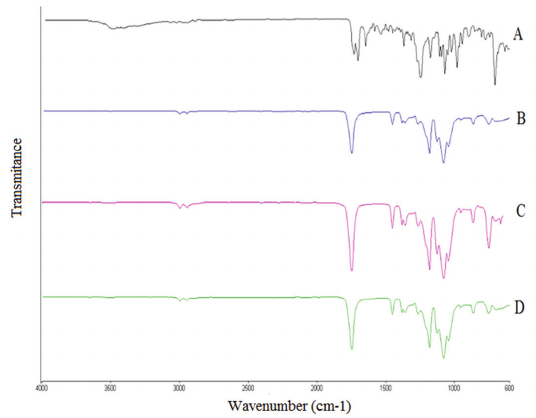
Figure 6. FTIR spectros of (A) pure paclitaxel, (B) PLDLA polymer alone, (C) PLDLA microspheres without paclitaxel, (D) PLDLA microspheres with paclitaxel.